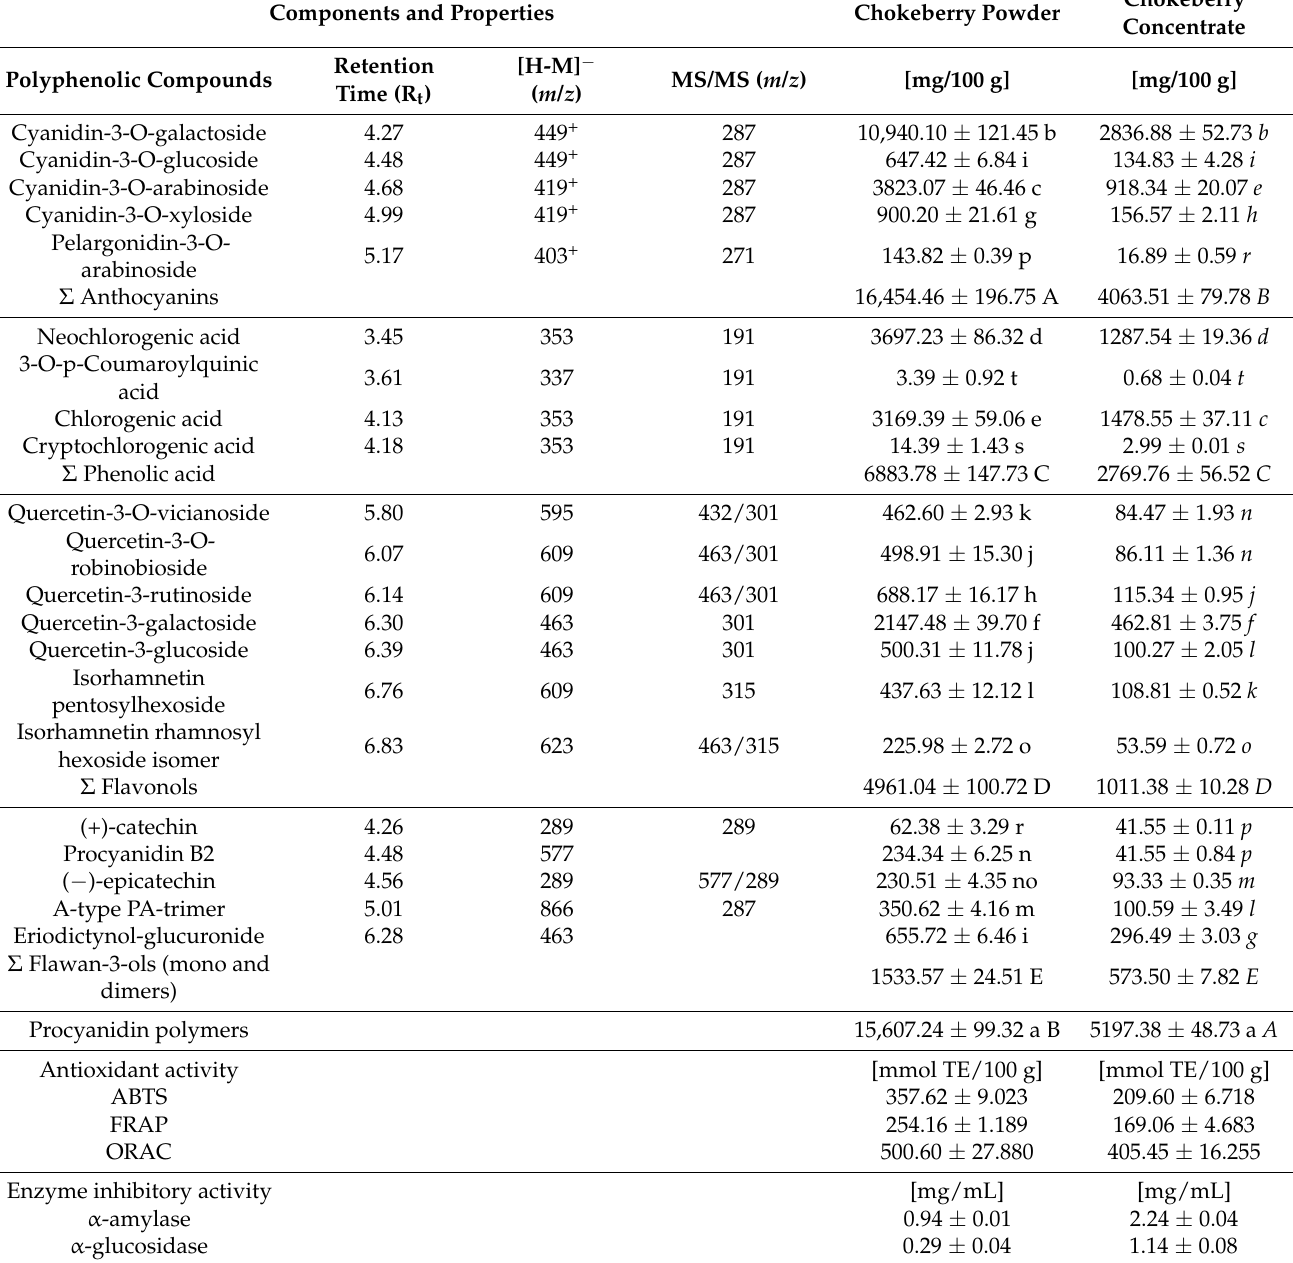
Table 2. Polyphenolic compounds (mg/100 g) and antioxidant activity (mmol TE/100 g) and anti- α -amylase and anti- α -glucosidase activities (IC 50 ) of chokeberry